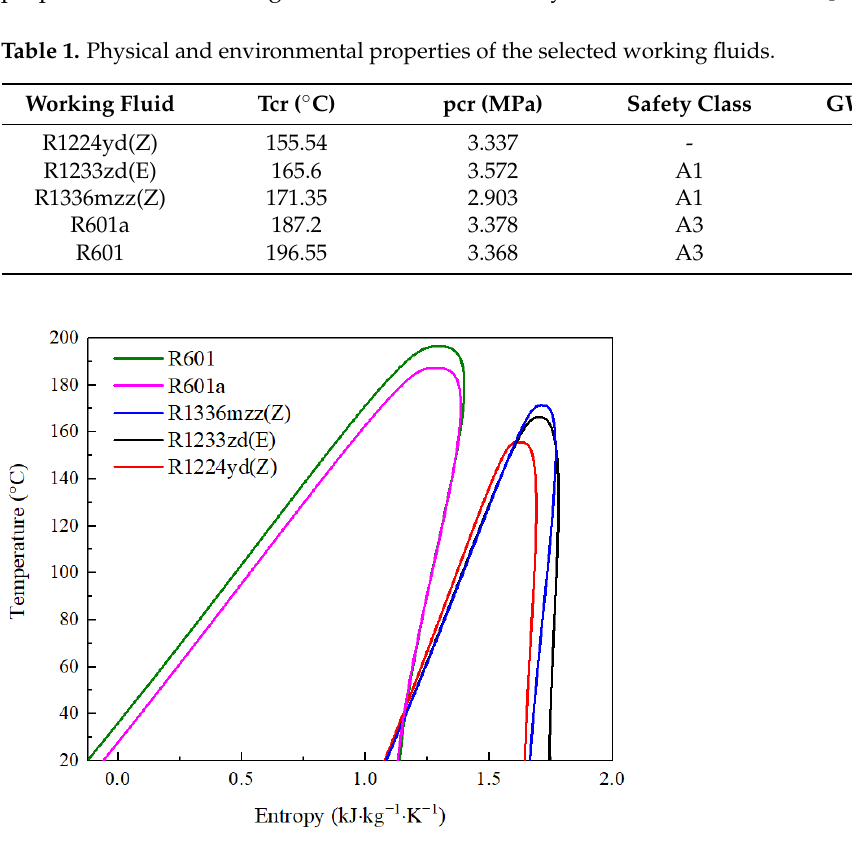
Figure 3. Saturation curves for the selected working fluids on the temperature – entropy